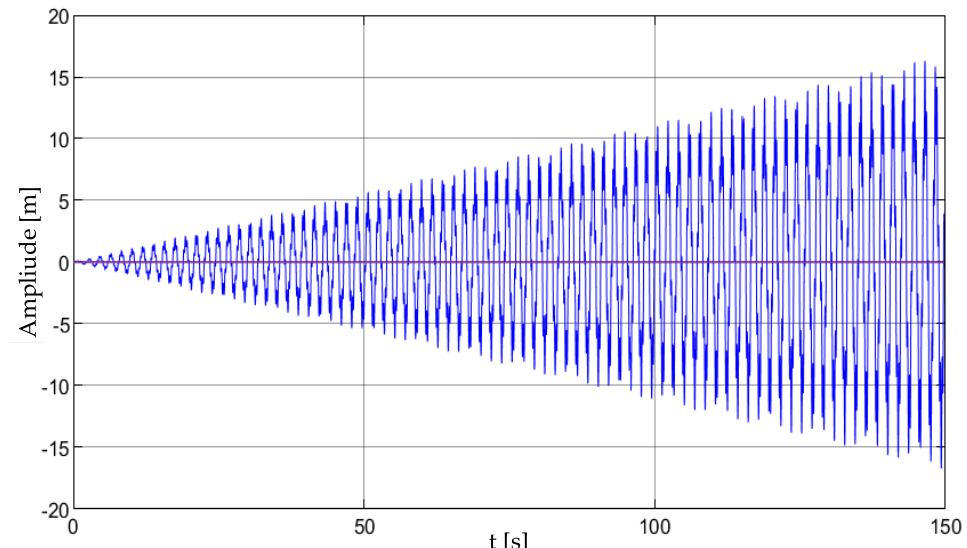
Figure 3. The object response to the dynamic excitation caused by para-seismic vibrations with the frequency of the first and second harmonics of the system at a maximum amplitude of 100 mm.